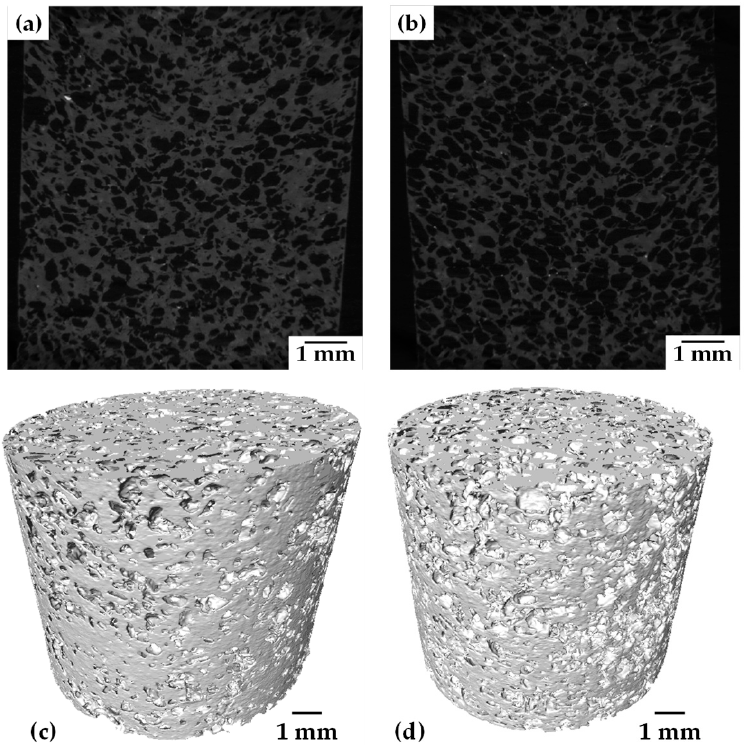
Figure 7. 2D virtual slices and 3D rendering of: ( a , c ) Ti00020Ta 30 vol.% salt; and ( b , d ) Ti20Ta 40 vol.% salt.